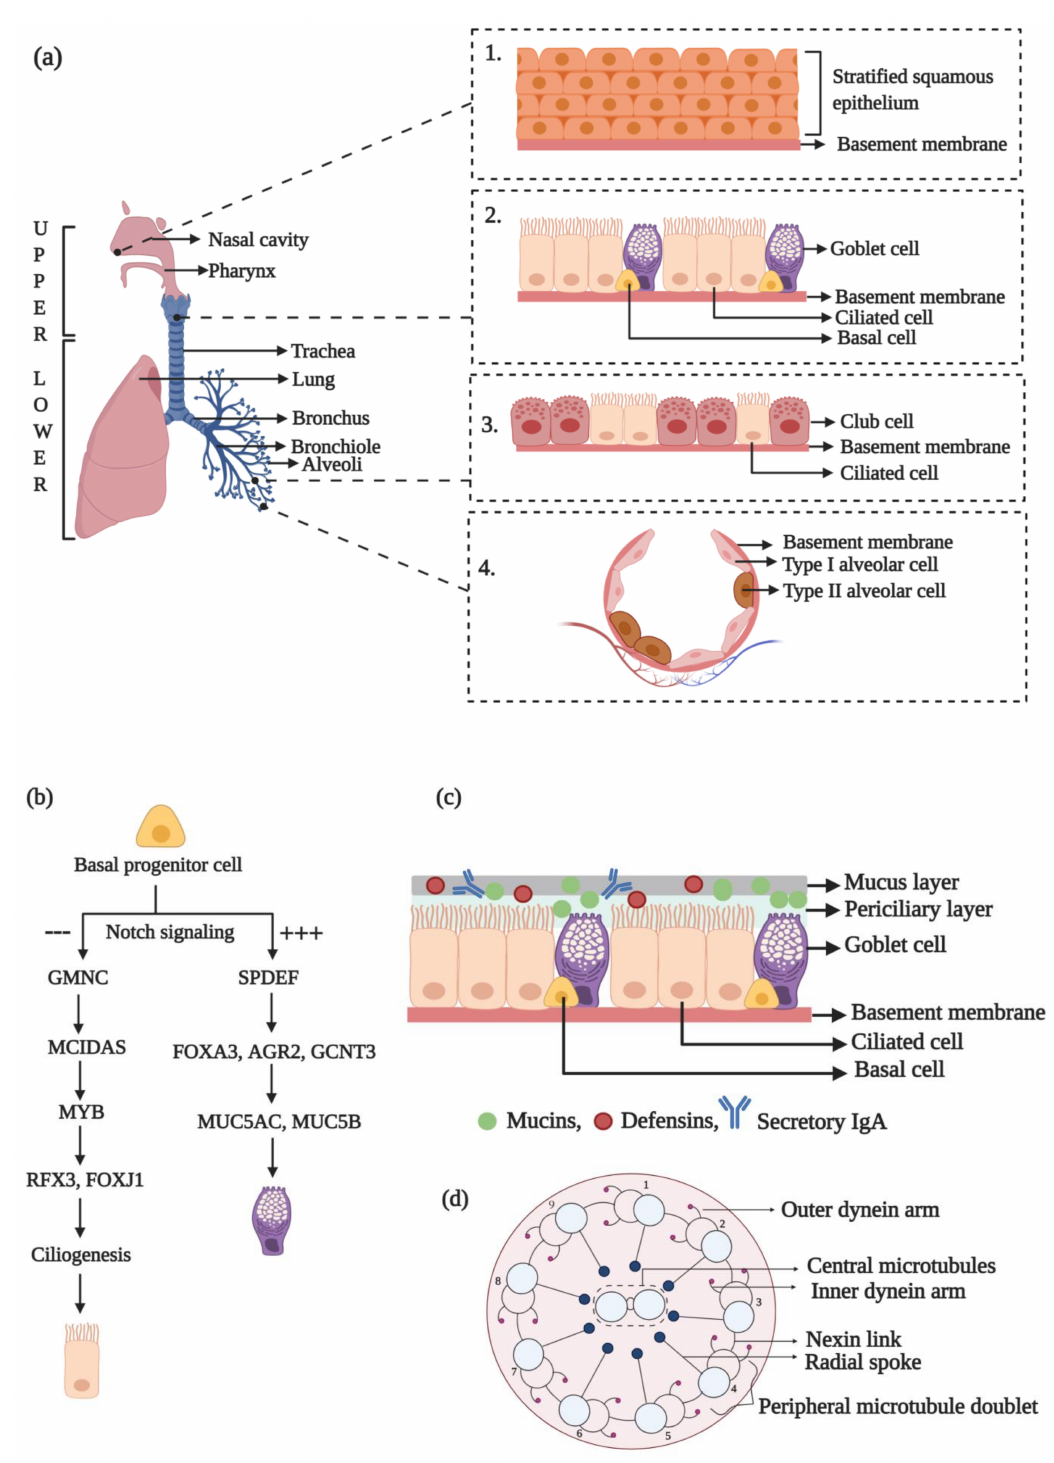
Figure 1. A pictorial visualization of the morphology and development of the components of the respiratory epithelium. ( a ) The human respiratory system comprises of the upper and lower respiratory tracts that collectively function to carry out gaseous exchange and also protect against air-borne infections. The nasal vestibule in the upper respiratory tract is lined by stratified squamous epithelium (Inset 1). It transitions into a pseudostratified columnar epithelial mucosa with ciliated and goblet cells lying on a basement membrane (Inset 2). The narrower bronchioles are lined by simple, cuboidal epithelium with less ciliated and more club cells (Inset 3), while the alveoli are composed of type I and type II alveolar cells (Inset 4). ( b ) Development of ciliated and goblet cell lineages. ( c ) The mucociliary escalator. ( d ) The 9 + 2 microtubular organization of a motile lung cilium. Illustration made using